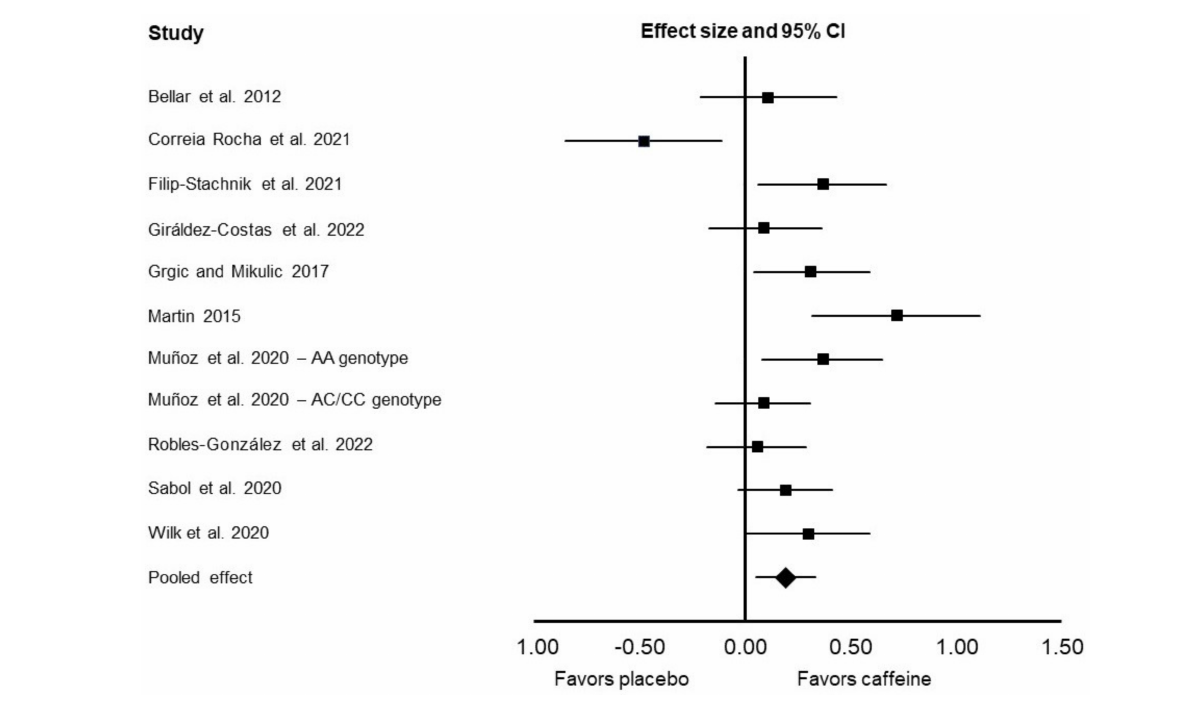
Figure 2. The forest plot presents the results of the random-effects meta-analysis that compared the effects of caffeine ingestion vs. placebo on throwing performance. The results are presented as standardized mean differences (effect size) and their 95% confidence intervals (CI). The squares present effect sizes and the whiskers are 95% CI. The diamond-shaped effect size represents the overall (pooled) effect, which indicates favoring of caffeine when compared to placebo for throwing performance. The meta-analysis was performed using data from ten included studies